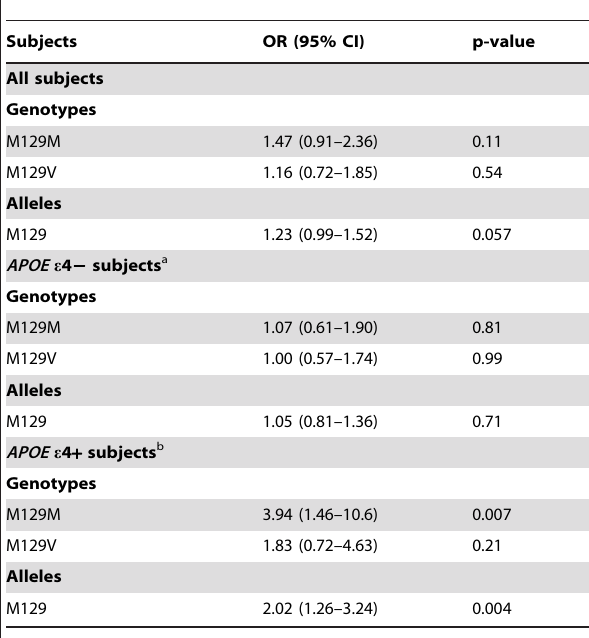
Table 3. Odds ratios for the association between Alzheimer’s disease and PRNP codon 129 in different strata defined by APOE e 4 allele status (V129V genotype and V129 allele are taken as reference or non-exposed).